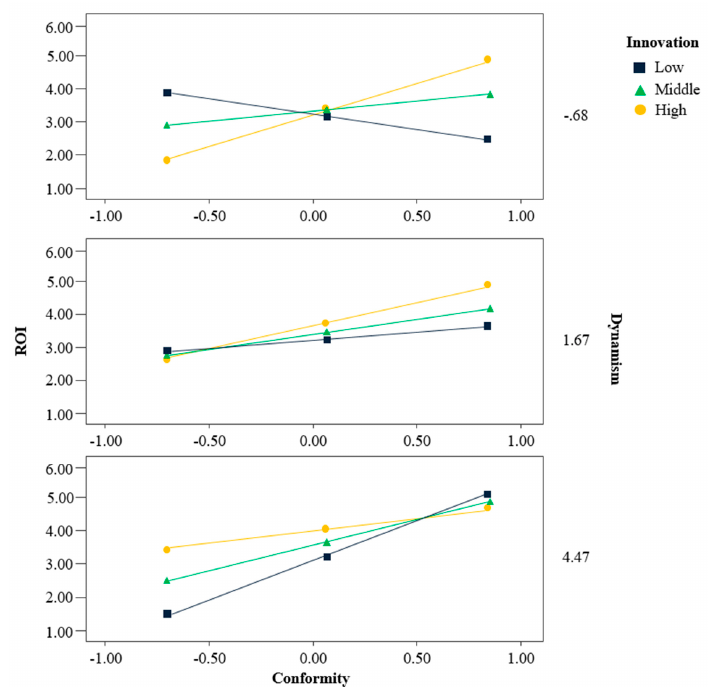
Figure 3. Three-way interaction effects; Conditional effects of strategic conformity and innovation on the performance of firms at three different levels of dynamism. To further present how the interaction effect between conformity and innovation on performance depends on the level of industry dynamism, we identified regions of significance for interaction effects across the entire range of the moderator by employing the Johnson–Neyman technique [74] using PROCESS Macro [75]. According to the findings in this analysis (Table 3), the interaction effects of strategic conformity and innovation in the performance of sample firms are statistically significant when the level of dynamism is at W ≤ 0.032 and W ≥ 1.673. The results also show that the interaction effect of conformity and innovation is highest at the lowest value of dynamism (W = − 0.676), decreases as the value of dynamism increases, and finally shows a negative effect from the value of dynamism at 0.612 (See Table 3). Table 3. Moderating Effect based on Johnson-Neyman Technique.